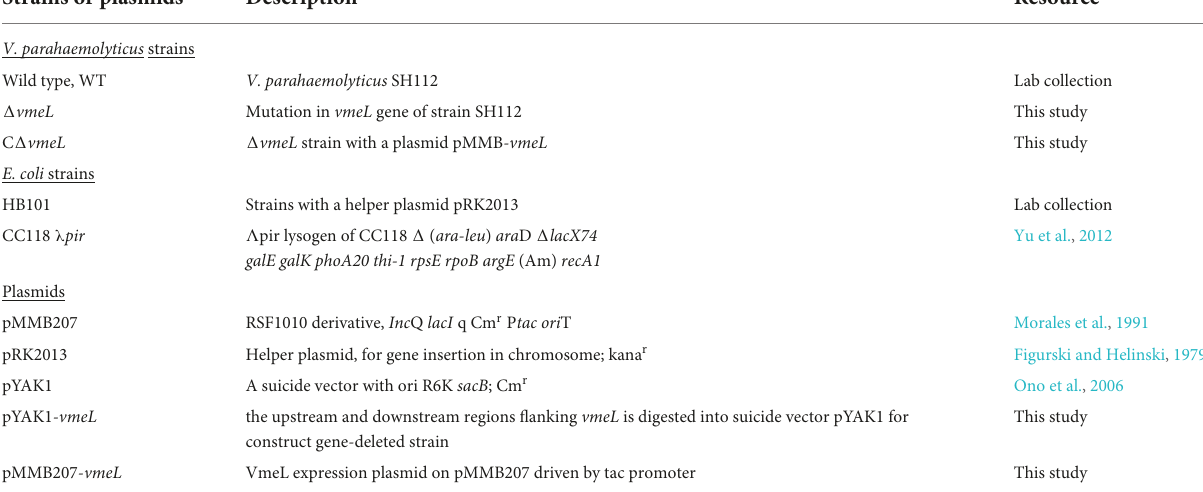
TABLE 1 Bacterial strains and plasmids.